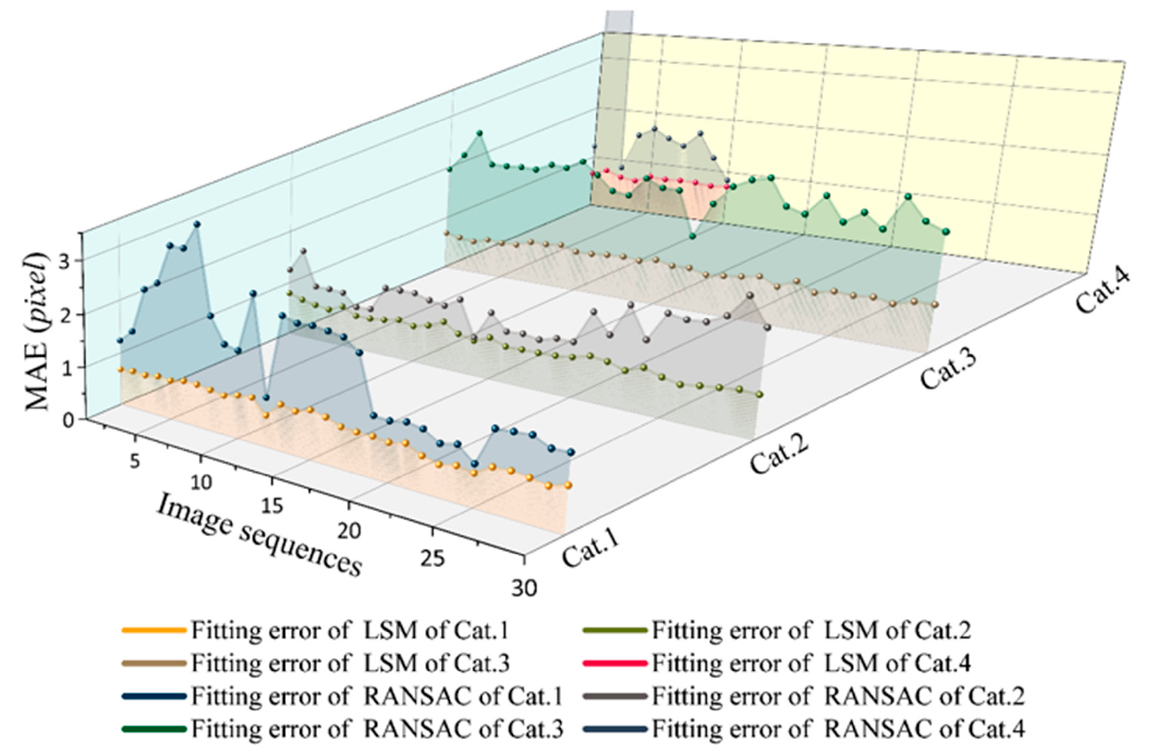
Figure 12. Comparison of fitting error between LSM and RANSAC algorithms for four categories of wafer images, where LSM is Least Squares Method.